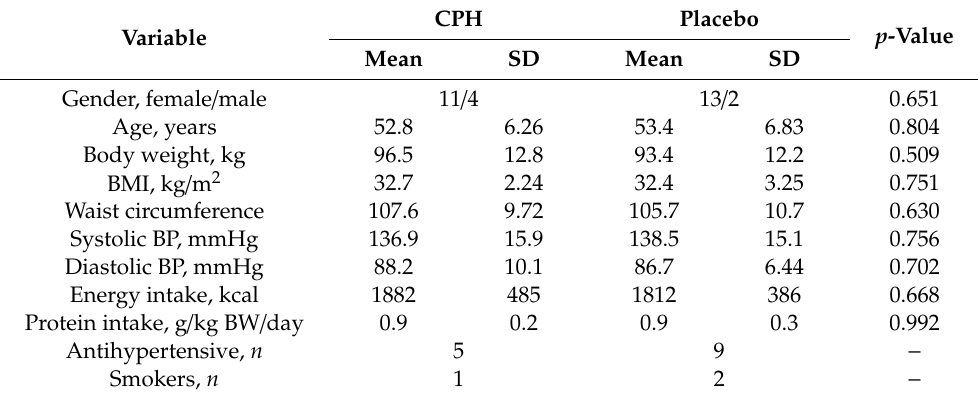
presented as mean ± SD. Groups were compared at baseline using Independent Samples t -test.